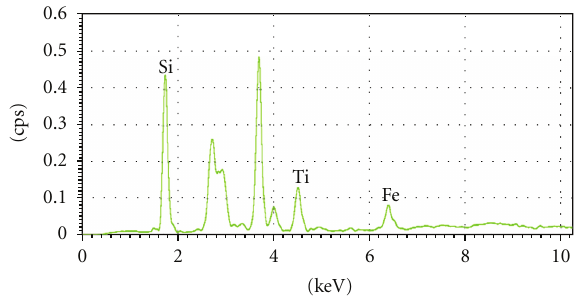
Figure 3: XRF spectrum of 0.3% Fe-TiO 2 on a glass slide.